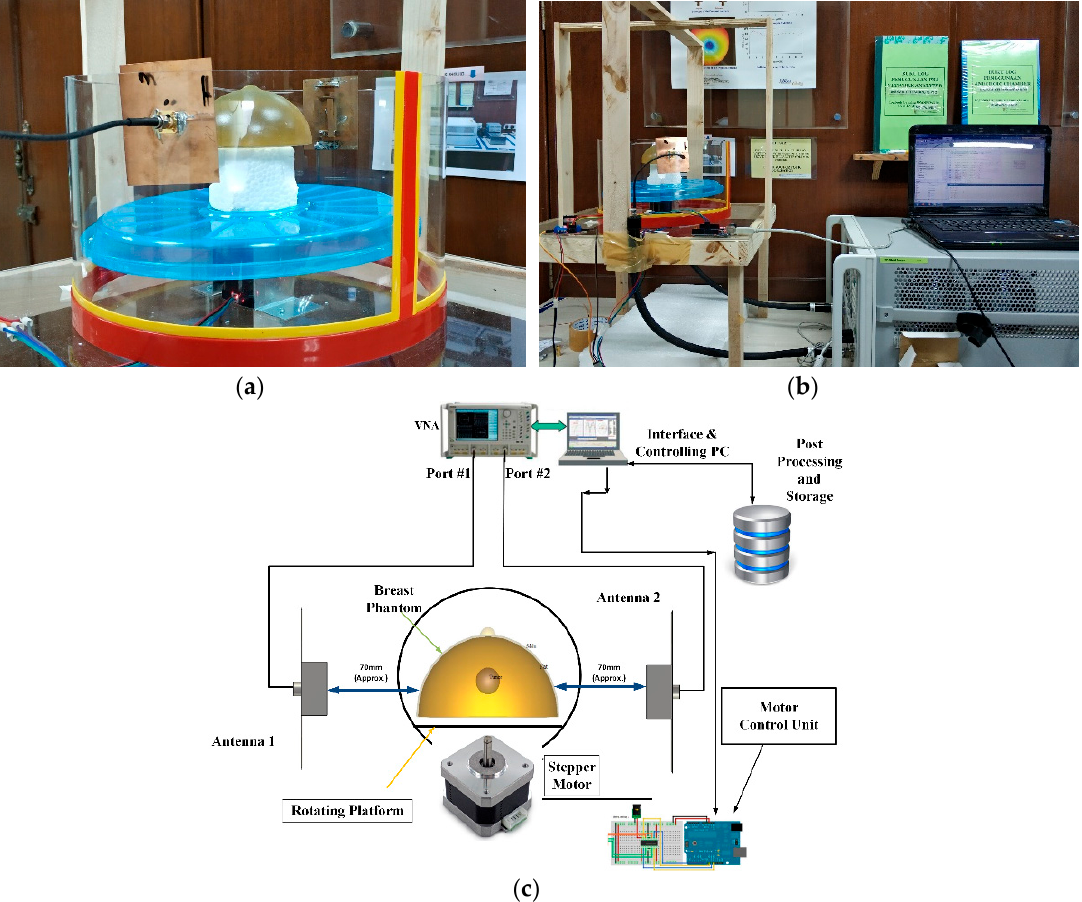
Figure 13. ( a ) Breast phantom placed between two sensor antennas; ( b ) experiment setup; ( c ) block diagram of the experimental setup.